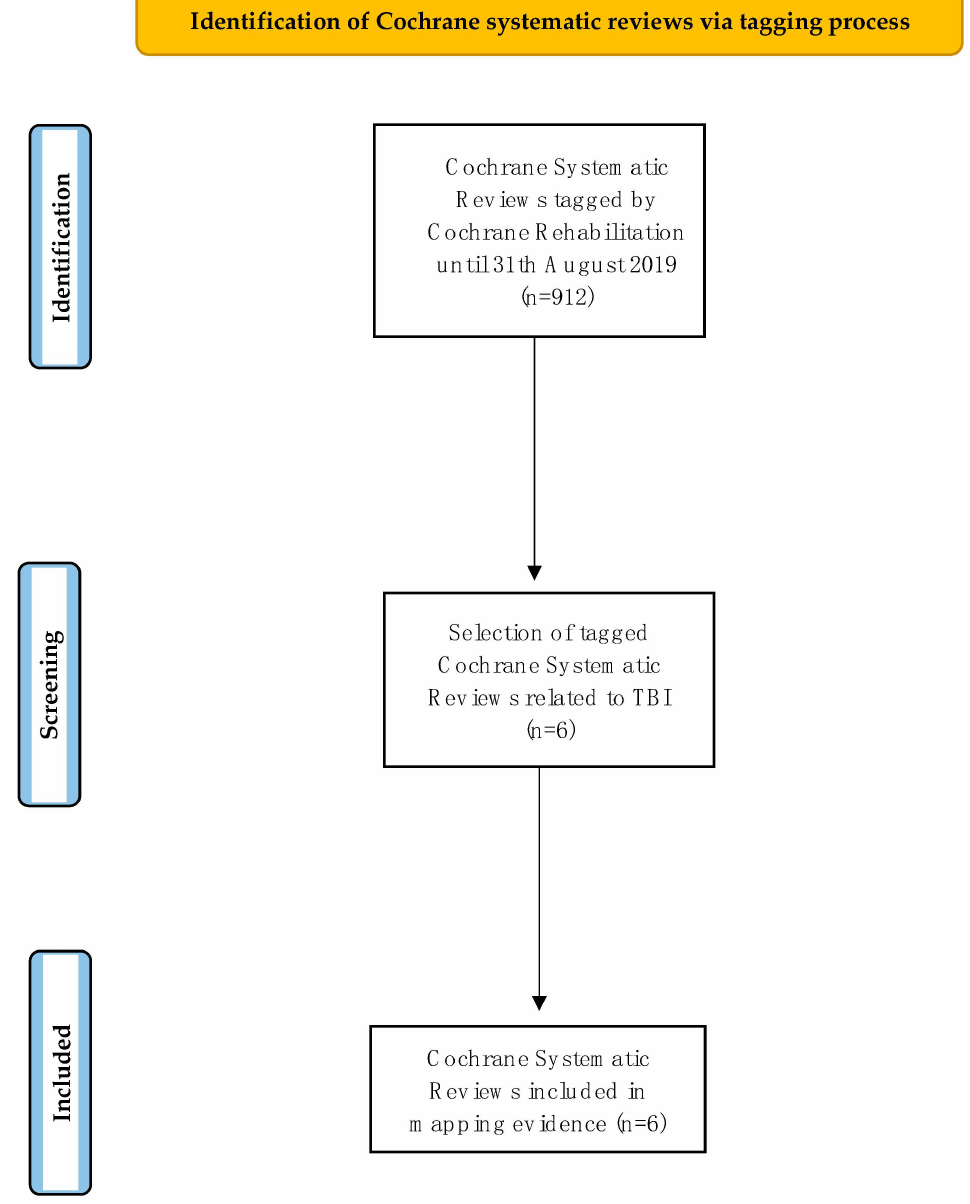
Figure 1. Flow chart displaying the tagging process of Cochrane systematic